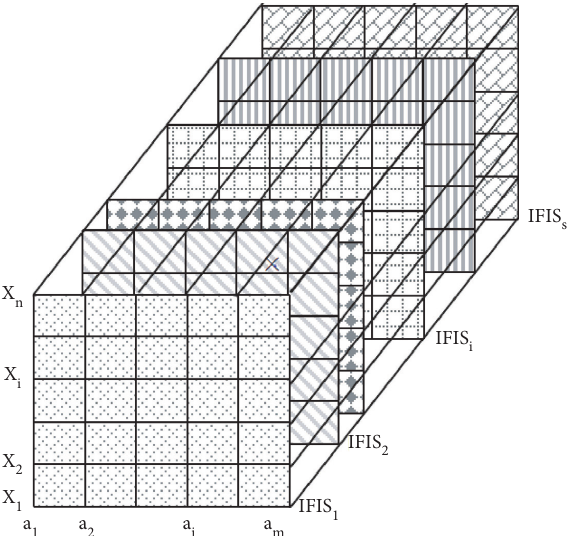
Figure 1: A multisource intuitionistic fuzzy information